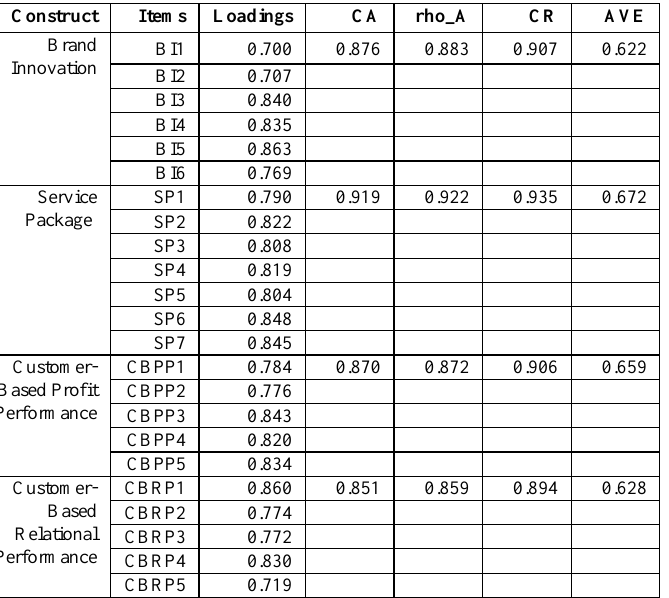
Table 1: Reliability and Validity Test